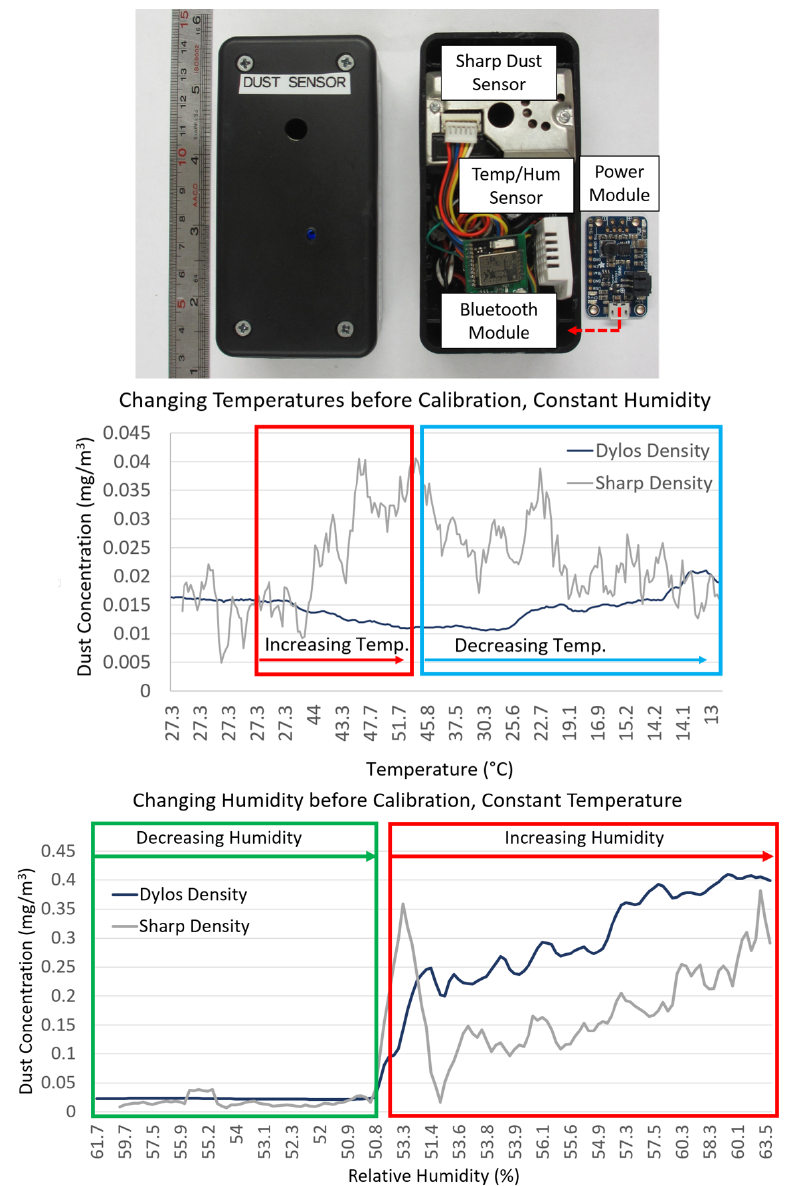
Figure 2. ( Top ) Custom-built wireless dust sensor for dust density data prototype design and circuit diagram. Calibration experiments performed: ( Middle ) Dylos and dust sensor exposed to increasing and decreasing temperatures while humidity and dust concentrations are kept constant; ( Bottom ) Dylos and dust sensor exposed to increasing humidity while temperature and dust concentrations are kept